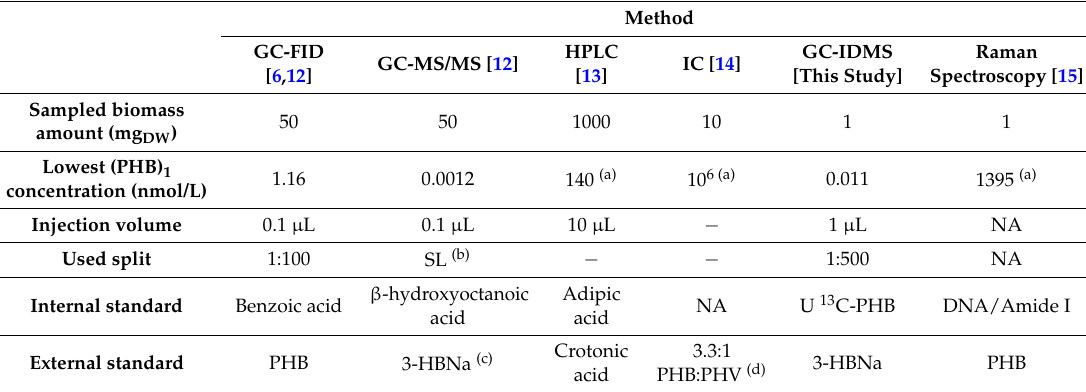
Table 1. Comparison of most common approaches for PHB quantification in biomass. The concentration is given as molar monomer units (PHB) 1